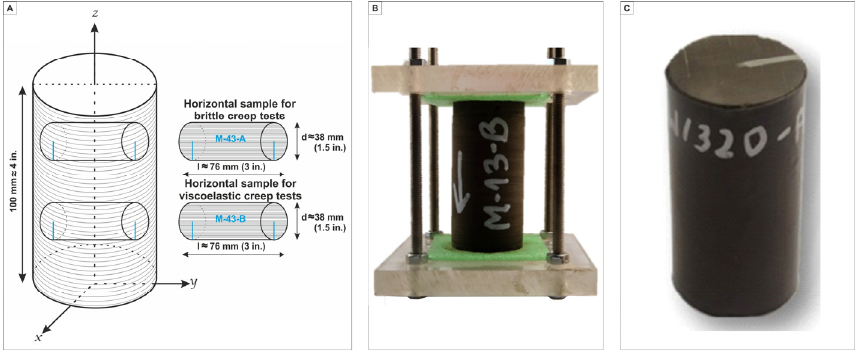
Figure 4. ( A ) Scheme of preparing samples for laboratory tests, ( B ) protected sample for laboratory tests, ( C ) and a single sample sealed with a heat-shrink jacket.